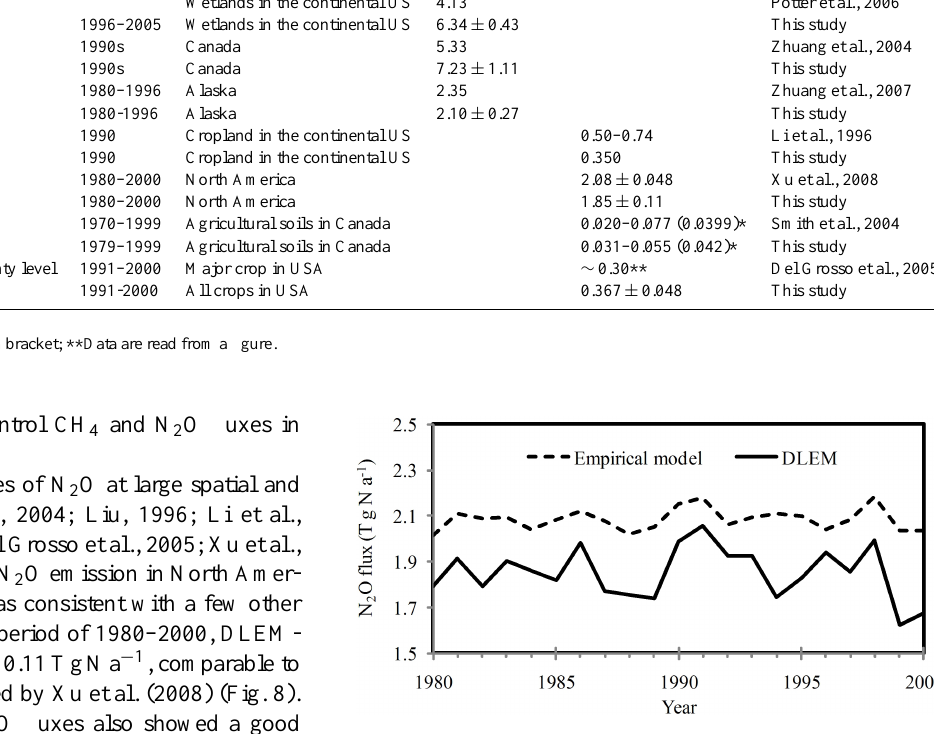
Fig. 8. Comparison of the DLEM-derived N 2 O fluxes with the es- timations by an empirical model (Xu et al., 2008). The regression model is: the DLEM-derived N 2 O=0.8887 × Empirically-modeled N 2 O, R 2 =0.39; P <